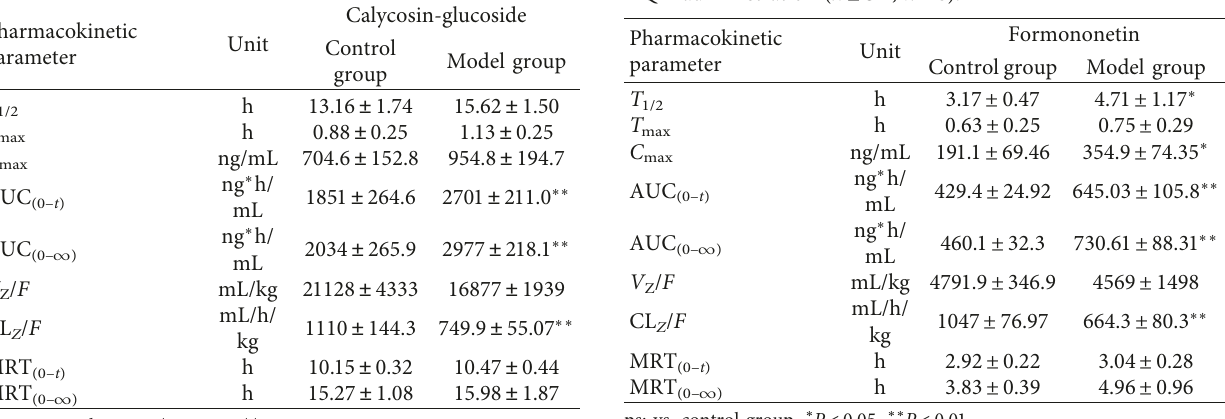
Table 11: The pharmacokinetic parameters of formononetin after HQD administration ( x ± SD, n �